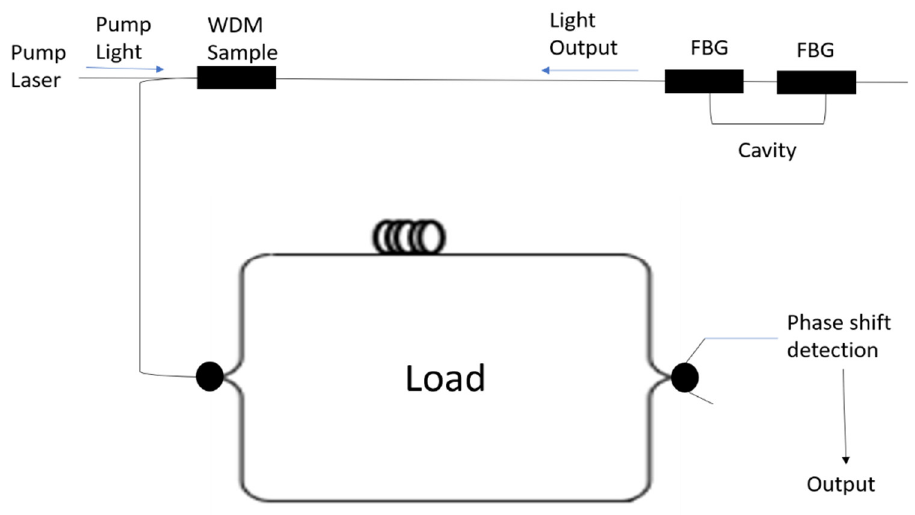
Figure 6. Interferometric Interrogation along with WDM [57].